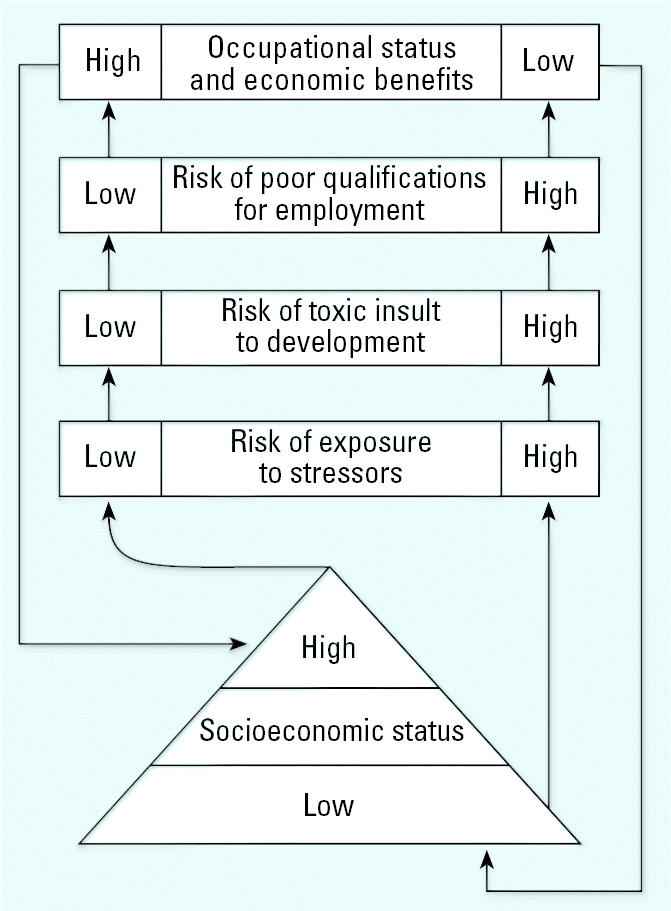
Risk-focusing model.